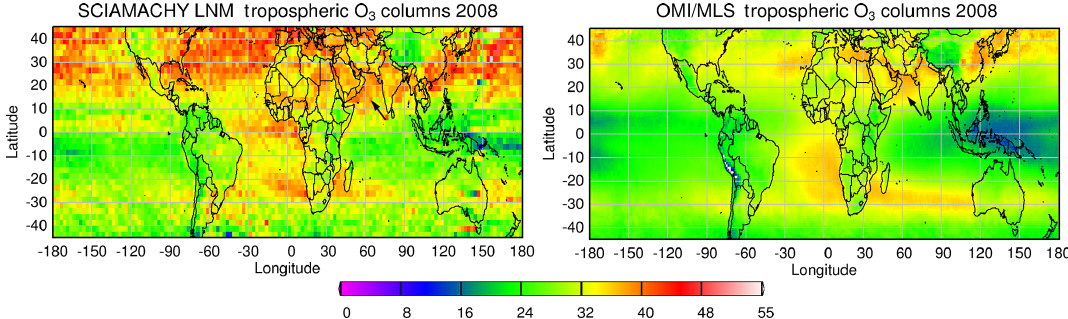
Figure 1. Yearly average for TOC retrieved from (left) SCIAMACHY LNM and (right) OMI/MLS in 2008, with bold arrows pointing to AS. The AS region is defined as 10–20 ◦ N, 60–70 ◦ E in this study and is marked with a red rectangle in Fig.